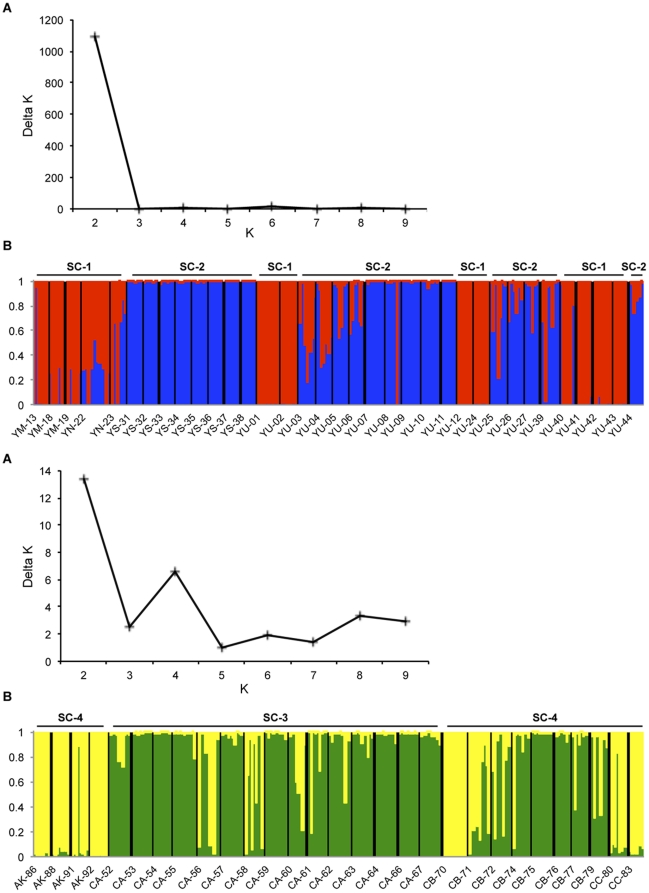
Inference of the number of genetic clusters (K) in populations of P. megacephala var. 1 (i.e. urban) (top) and P. megacephala var. 2 (i.e. rainforest) (bottom).A. ΔK (the standardized second order rate of change of ln P(X|K)) is plotted as a function of K. B. Proportional membership of P. megacephala workers to genetic clusters (K) for K = 2. Each vertical bar represents an individual whose estimated proportion of membership to either cluster (Y-axis) is indicated by the two different shades. Black lines separate individuals from different nests. Colours correspond to genetic clusters.